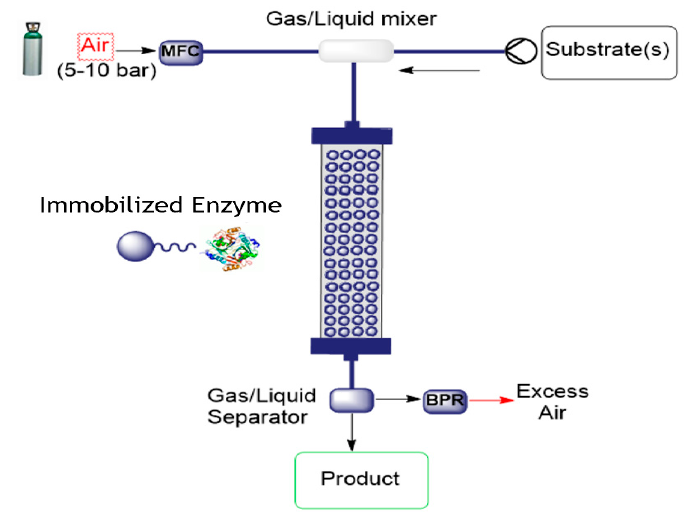
Figure 6. Flow set-up for air-mediated oxidation using immobilized enzymes (MFC = mass flow Figure 6. Flow set ‐ up for air ‐ mediated oxidation using immobilized enzymes (MFC = mass flow controller; BPR = back pressure controller; BPR = back pressure regulator).